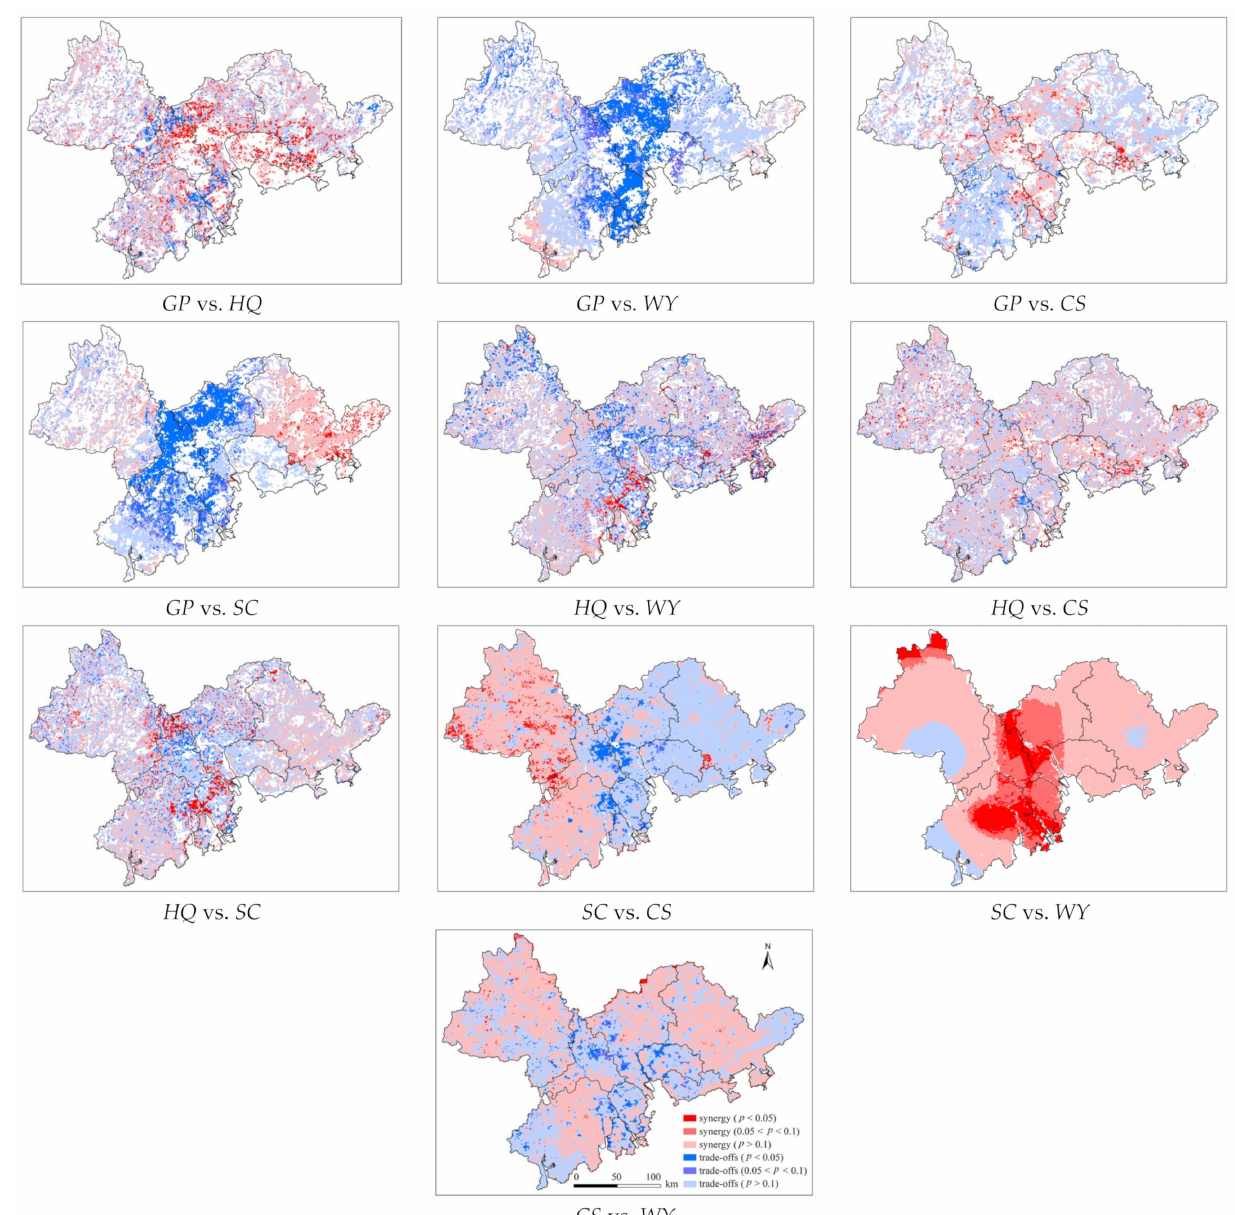
Figure 5. Spatial distribution of the ecosystem services trade-offs/synergies at grid level in the Pearl River